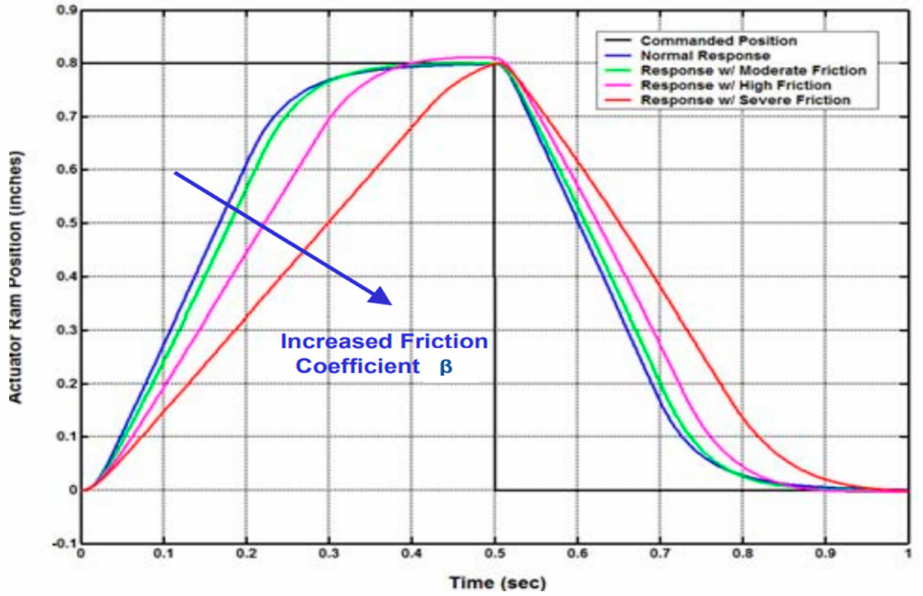
Figure 11. Actuator position against time for changing values of actuator bearing friction